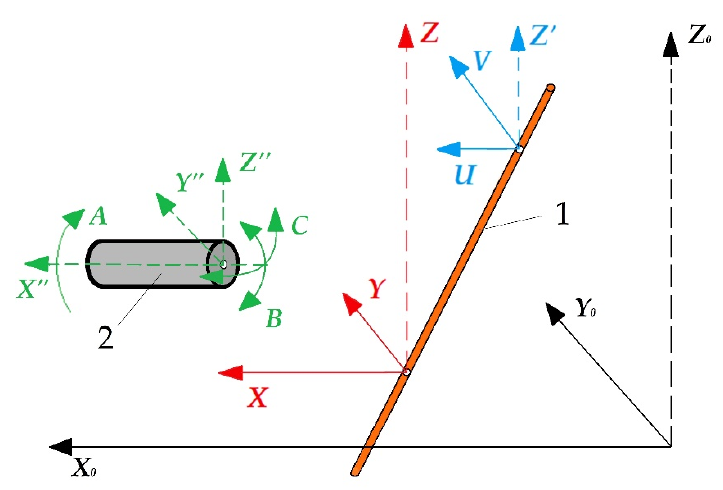
Figure 1. Additional rotary axes of wire electrical discharge machining: ( 1 ) is a tool, ( 2 ) is a part, X 0 Y 0 Z 0 is an absolute coordinate system of the machine, XYZ is a relative coordinate system of the lower wire attachment point, UVZ’ is an auxiliary coordinate system of the upper wire attachment point, X”Y”Z” is a relative coordinate system of the part, ABC is an additional rotary axes.